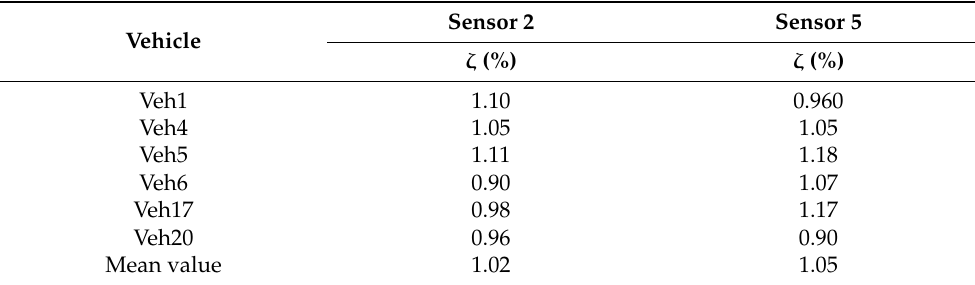
Table 10. Estimated damping ratios based on free vibration time histories.